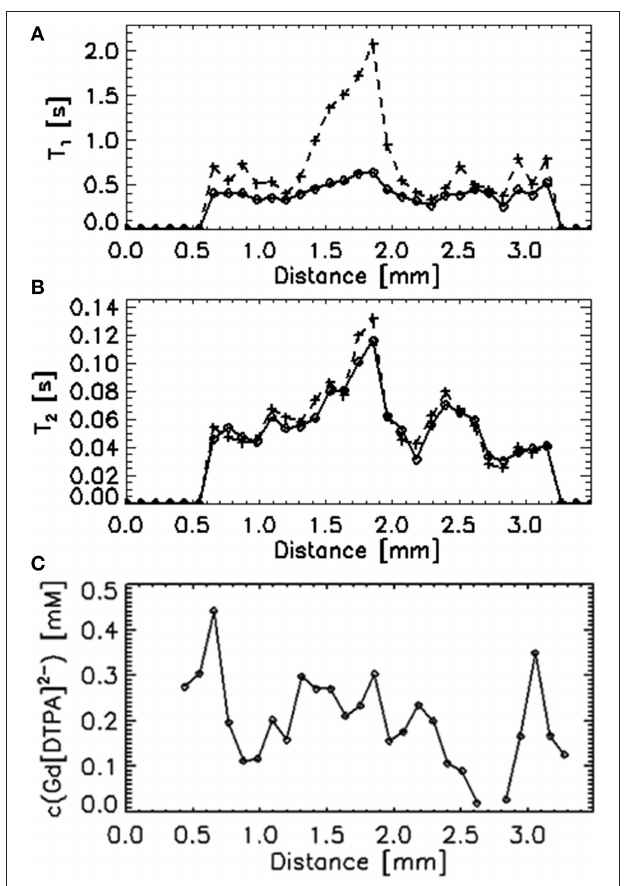
FIGURE 5 | Penetration of iron as (A) FeCl 2 , (B) [FeEDTA] 2 − , and (C) FeCl 2 /[FeEDTA] 2 − (0.25:1), and (D) cobalt as CoCl 2 into single methanogenic granules. Each curve depicts average values for a certain depth in the granule ranging from 0 µ m (edge) to 763 µ m (core). The dashed lines show the concentration of the given metal introduced into the liquid media at time